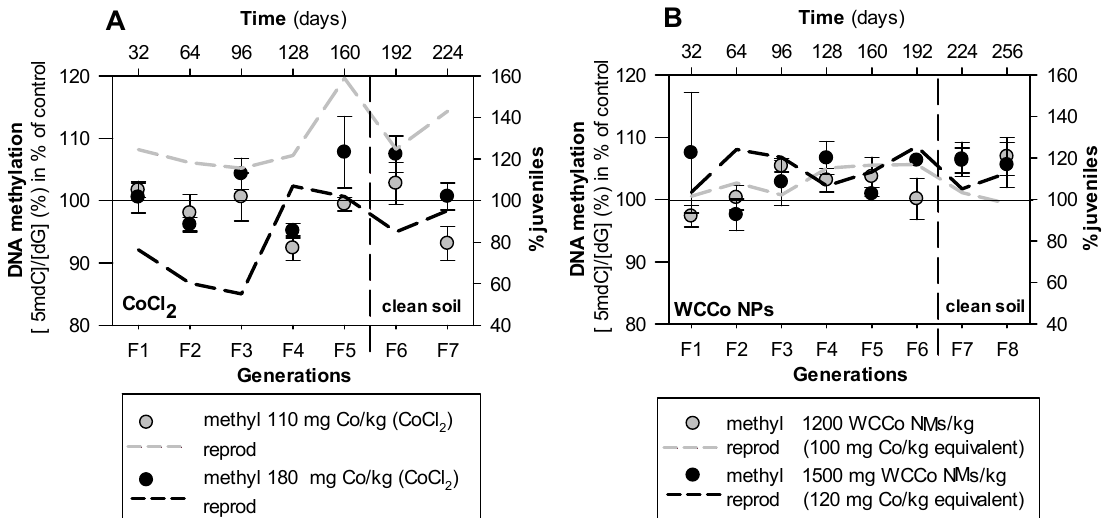
Figure 1. Global DNA methylation (LC-MS, Liquid Chromatography—Mass Spectrometry measurements) for Enchytraeus crypticus after multigenerational exposure to the reproduction EC 10 and EC 50 (and control samples) of ( A ) CoCl 2 (0–110–180 mg Co / kg soil DW) and ( B ) WCCo NMs (0–1200–1500 mg WCCo NMs / kg soil DW, 0–100–120 mg Co / kg equivalent) in LUFA 2.2 soil. All values are expressed as average ± standard error (Av ±